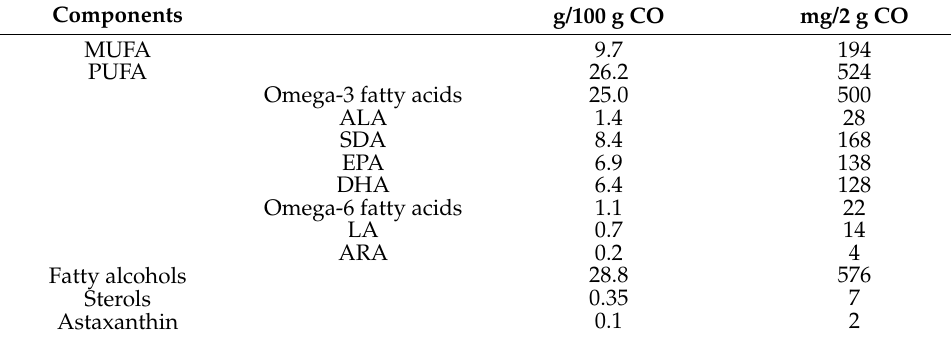
Table 1. Composition of Oil extracted form Calanus finmarchicus